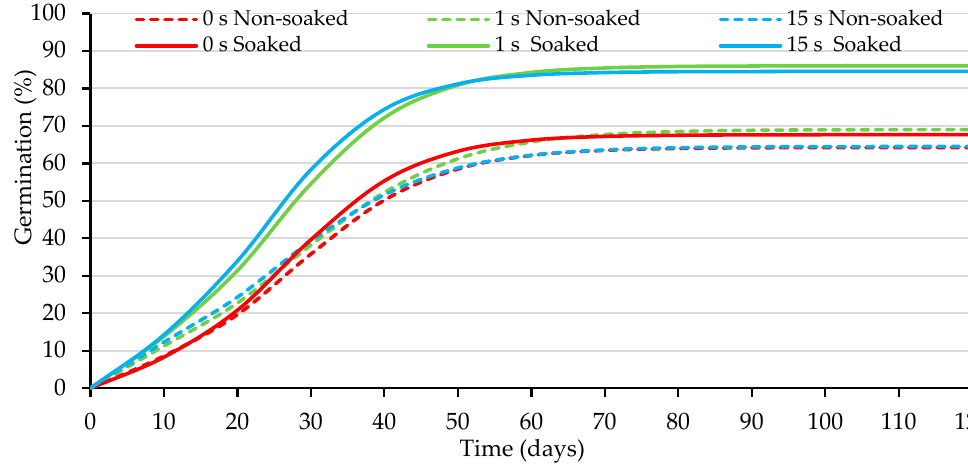
Figure 4. Logistic model adjusted to the curves of accumulated germination of caper seeds from Experiment 4. Average values corresponding to the combination of the exposure time of the seeds to the He-Ne laser irradiation (0, 1 or 15 s) after being soaked in water or not. A 500 mg L − 1 GA 3 solution was used to wet the substrate.